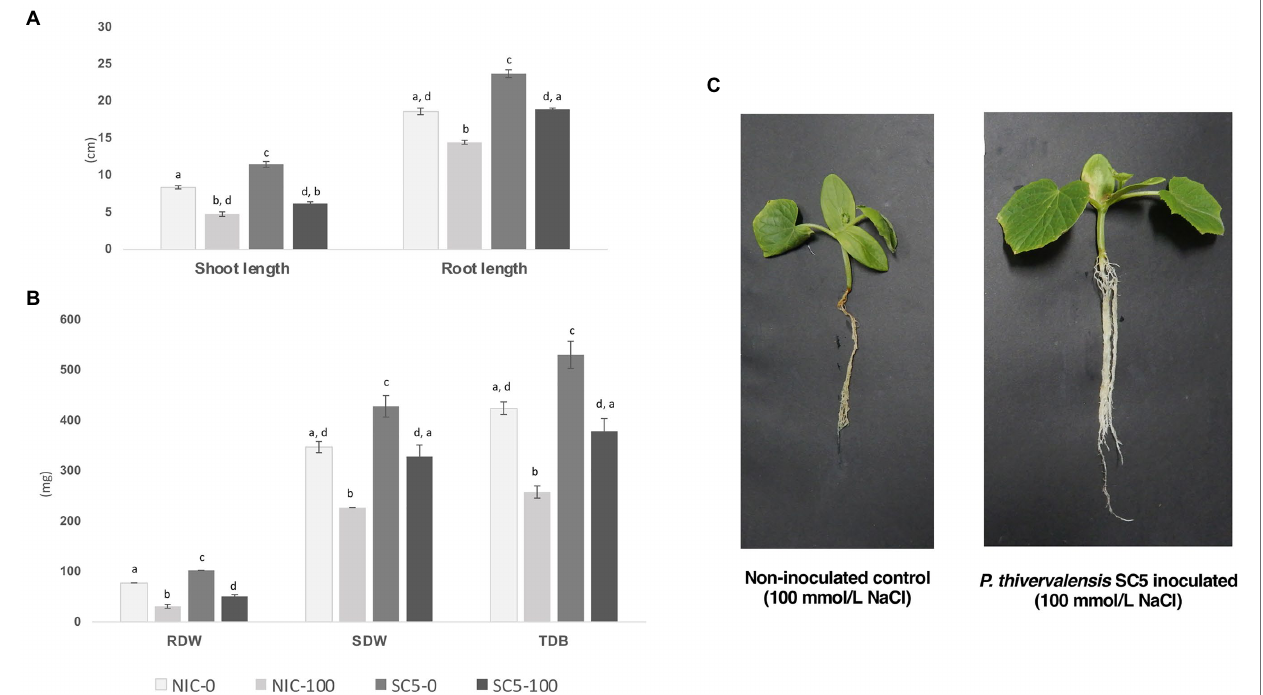
FIGURE 1 | Results obtained from a cucumber plant growth promotion assay performed under greenhouse conditions, 3 weeks after inoculation, six replicates. (A) Shoot and Root lengths (cm) of non-inoculated control and Pseudomonas thivervalensis SC5 inoculated plants under normal and salt stress conditions; (B) Root, shoot, and total dry biomass (mg) of non-inoculated control and P. thivervalensis SC5 inoculated plants under normal and salt stress conditions; (C) Non- inoculated control and P. thivervalensis SC5 inoculated cucumber plants under salt stress conditions (100 mM NaCl). NIC-0- non-inoculated control, normal conditions; SC5-0- P. thivervalensis SC5 inoculation, normal conditions; NIC-100- non-inoculated control, salt stress conditions (100 mM NaCl); SC5-100- P. thivervalensis SC5 inoculation, salt stress conditions (100 mM NaCl). RDW, root dry weight; SDW, shoot dry weight; and TDB, total dry biomass. Different letters adjacent to bars represent significant statistical differences ( p <